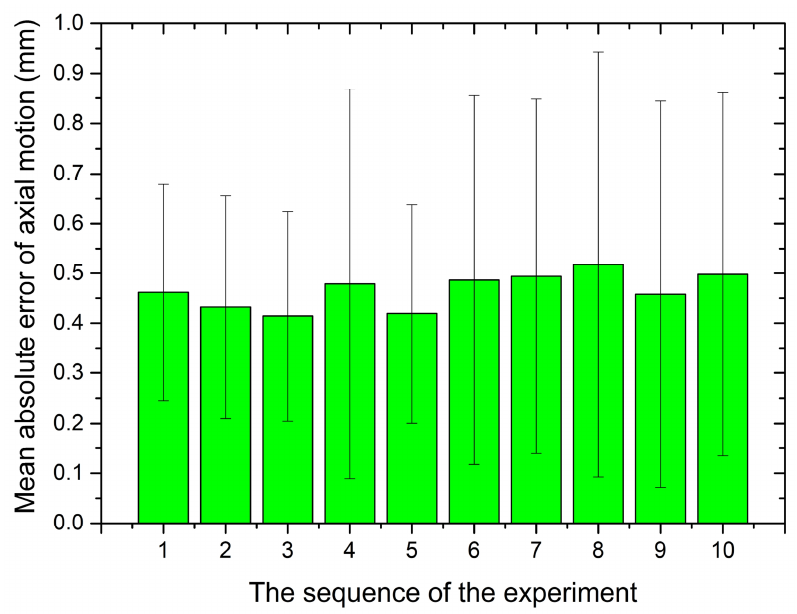
Figure 10. Mean error of ten times experiments for the axial motion.